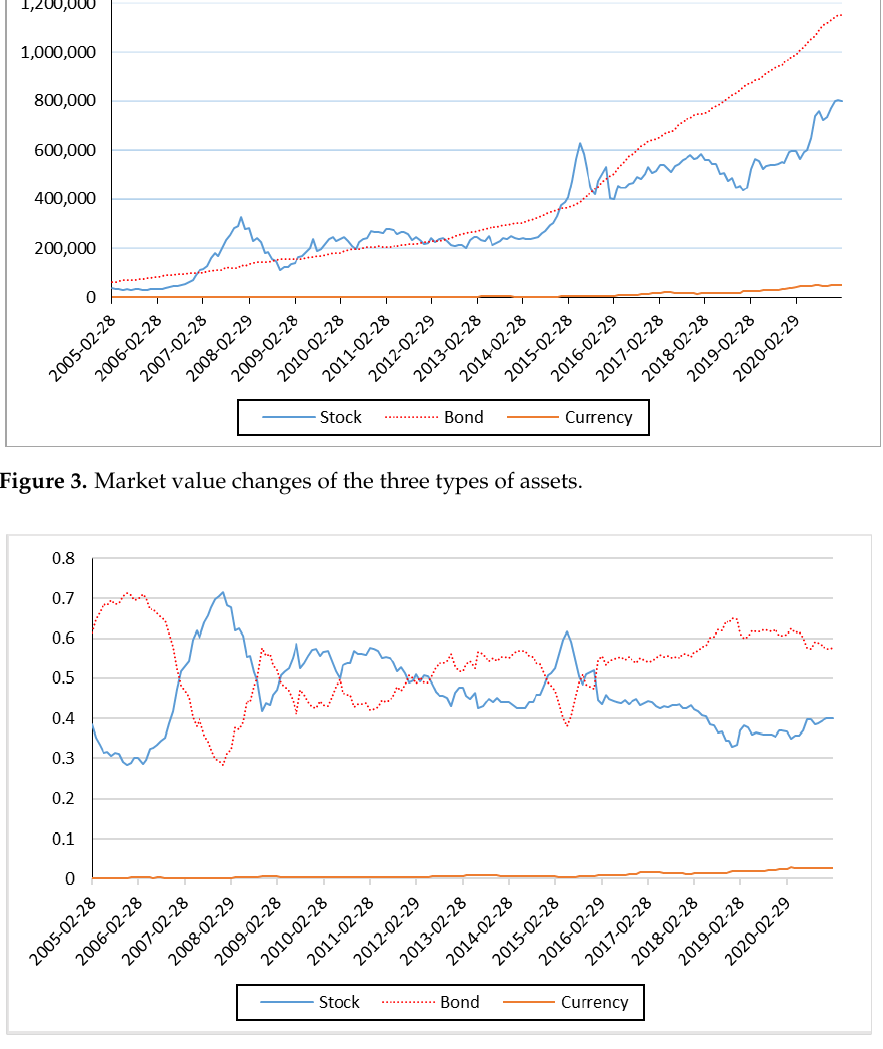
Table 4. The annualized rate of return and annualized volatility of the proposed model and the models for comparison.